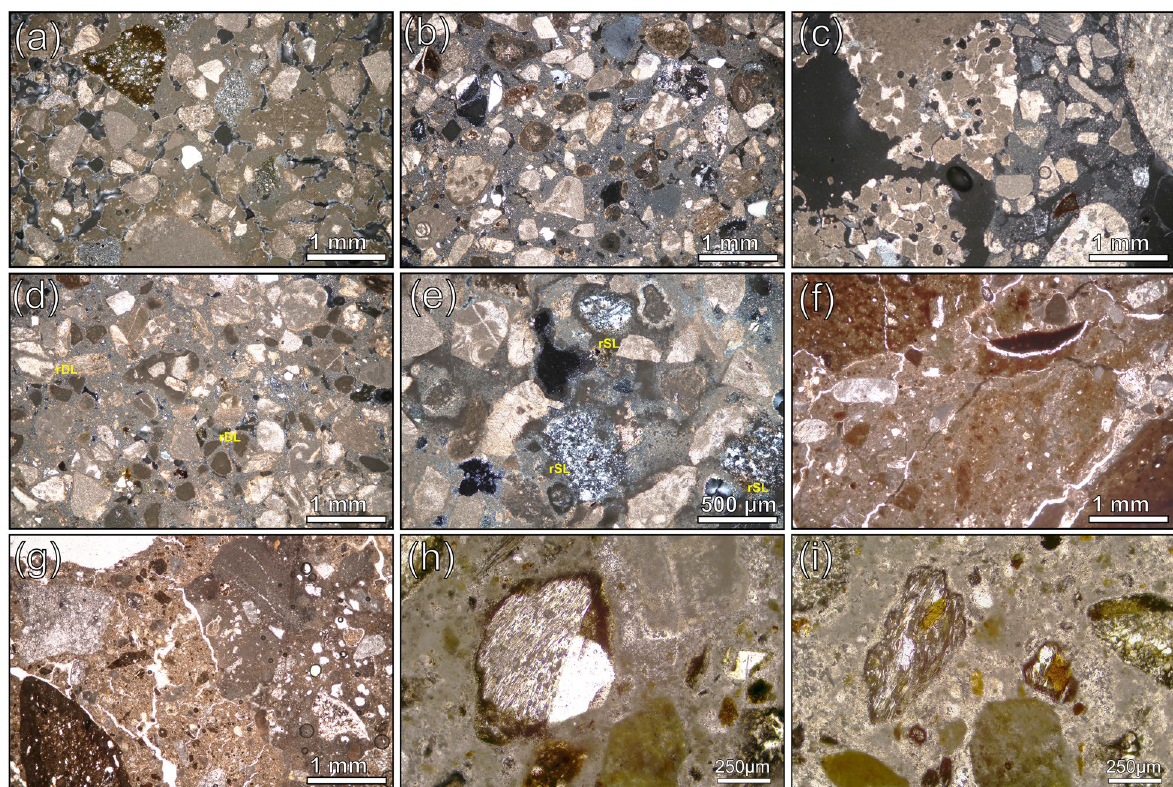
Figure 3. Detailed micrographs of representative samples by Polarized Light Microscopy (PLM), both in crossed (XN) and parallel (PN) nicols. ( a ) WM_11 (XN). The lime matrix displays high birefringence colors, indicating a complete carbonation of the binder. The aggregate is mainly represented by medium-to fine clasts of limestones or dolostones and silicate sand, with chert prevailing over quartz; ( b ) PREF_11 (XN). The lime matrix displays low birefringence colors, indicating an incomplete carbonation of the binder; ( c ) WM_15 (XN). Unburned fragment of dolomitic limestone, with relicts of rhombohedral crystals of dolomite. The lime matrix displays low birefringence colors; ( d ) WM_12 (XN), reacted clast of dolostones (rDL) having low birefringence due to dedolomitization phenomena; ( e ) PREF_8. Reaction rims around clasts of chert (rSL), having low birefringence; ( f ) PREF_13B (PN). The terracotta component of the sample is abundant, with scattered coarse clasts (at the corners of the picture) and diffused terracotta powder, intimately mixed with the lime matrix; ( g